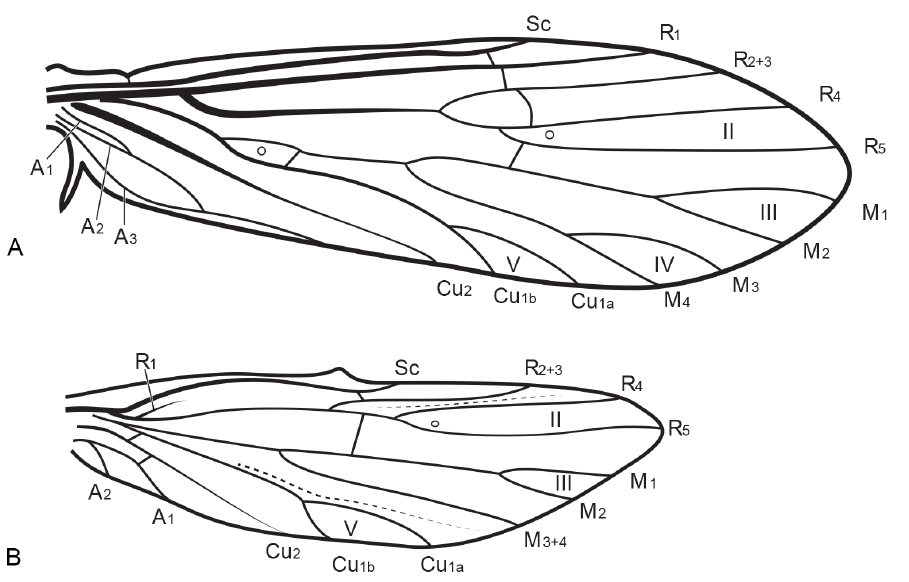
Figure 1. Wing venation of Metalype truncata sp. n., right wings, dorsal. A forewing B hind wing.